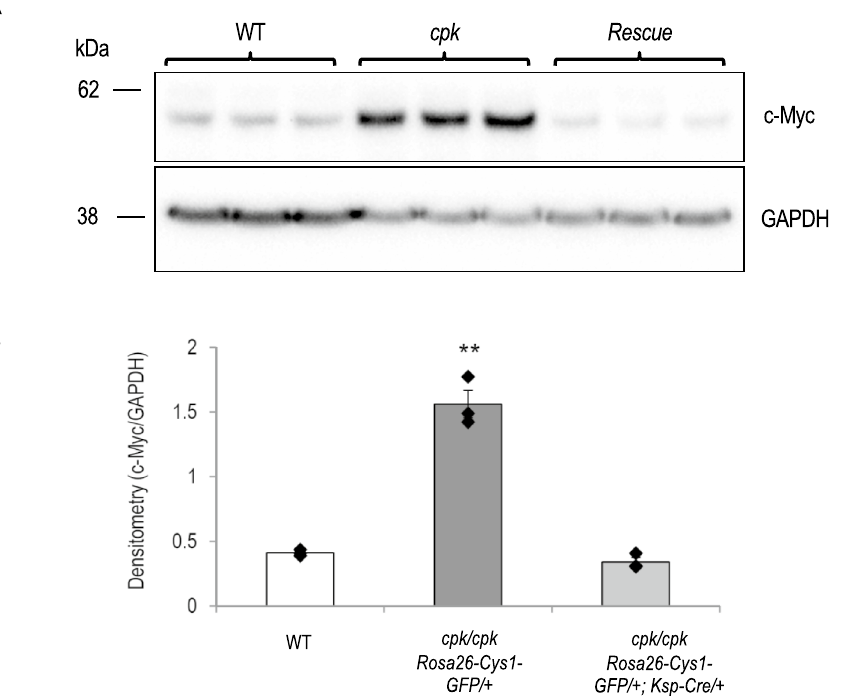
Figure 4. Decreased c-MYC expression in kidneys of cpk rescue mice. Immunoblot analysis of c-MYC protein expression in kidneys from wild-type (WT), cpk/cpk ; Rosa26-Cys1-GFP/ + ( cpk ) and cpk/cpk ; Rosa26- Cys1-GFP/ +; Ksp-Cre/ + (Rescue) mice. ( A ) Total kidney lysates were immunoblotted using anti-c-MYC and anti-GAPDH antibodies. ( B ) c-MYC band intensity was normalized with GAPDH. Data represents mean ± S.E; Y-axis values indicate c-MYC/GAPDH band intensity ratio; ** P < 0.01, versus others, ANOVA, n = 3 each